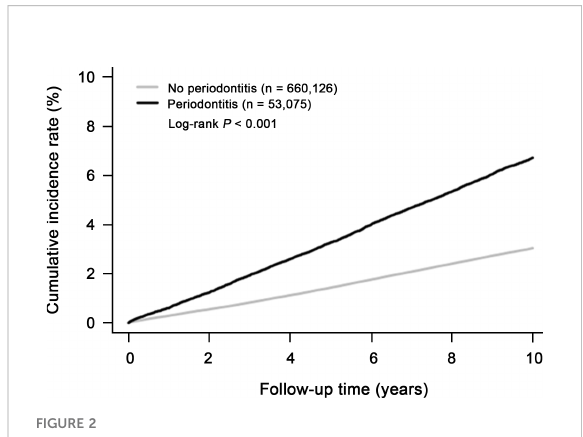
FIGURE 2 Cumulative incidence of overall cancer in subjects with periodontitis (n=53,075) and without periodontitis